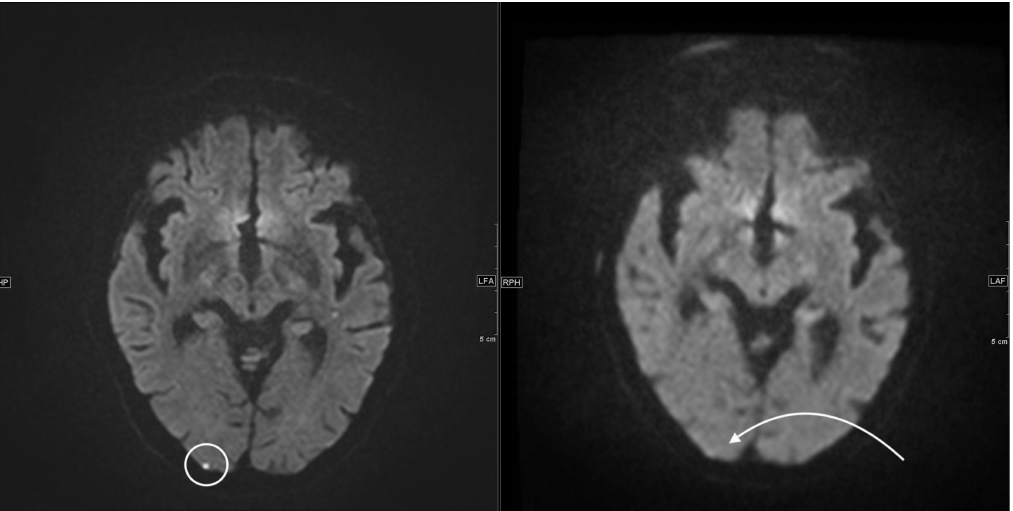
Figure 5. Left side, axial 1.5 T DWI sequence with sharply hyperintense delineable, punctiform DWI lesion located cortico-subcortical occipital right. On the right side, corresponding 0.55 T axial DWI sequence with the same slice localization without sufficiently detectable